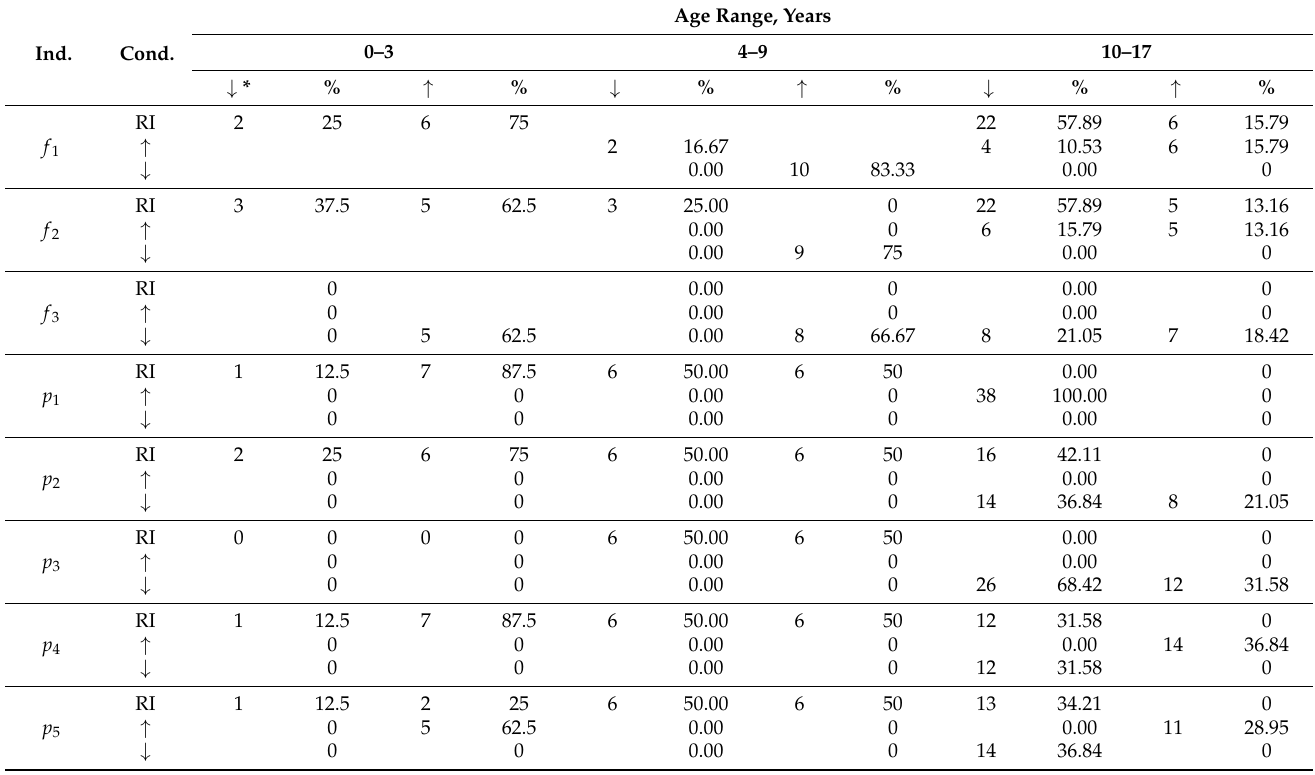
Table 4. Immunogram analysis for the state of the immune system k 2 .